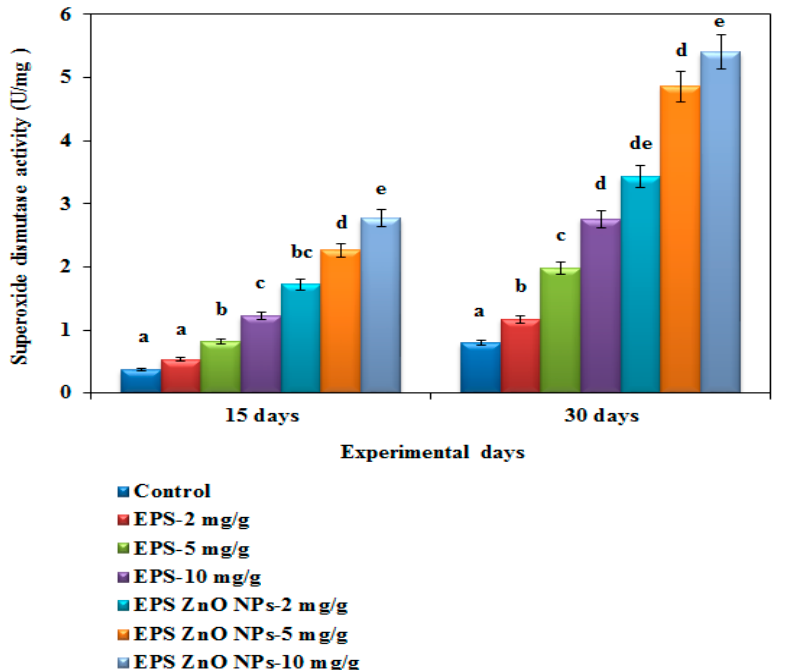
Figure 8. Superoxide dismutase activity (SOD) of O. mossambicus fed with EPS and EPS-ZnO NPs. T-bars indicate three replicates of mean ± SD, and different letters correspond to the statistical difference between treated groups.